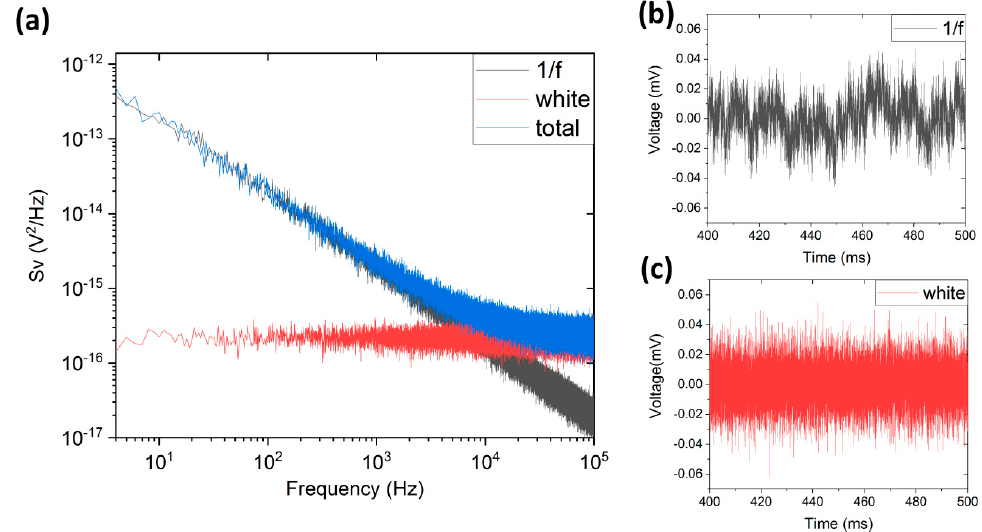
Figure 2. An example frequency-domain output ( a ) generated by 1/f-like stochastic process ( b ) and white noise-like stochastic process ( c ).